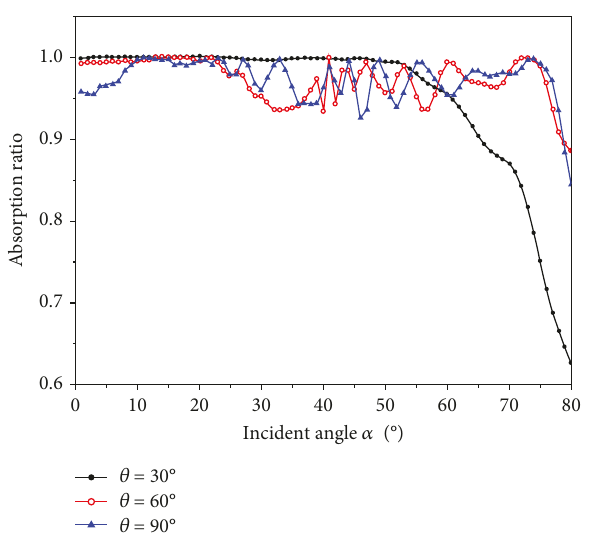
Figure 7: Absorptivity varying curve along with incident angle.